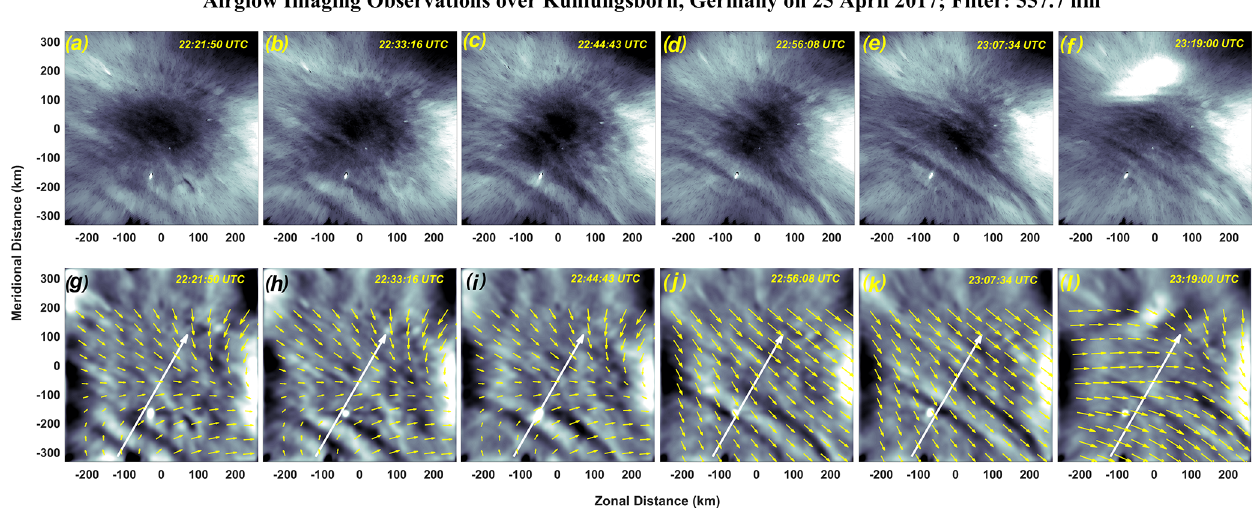
Figure 2. (a–f) Sequence of O( 1 S) 557.7nm airglow images on 25 April 2017 over northern Germany. (g–l) Corresponding 2D FFT filtered images overlaid on horizontal variation of wind field (yellow arrows) at the emission centroid height (97km) measured by MMARIA. The white arrow denotes the wave vector.